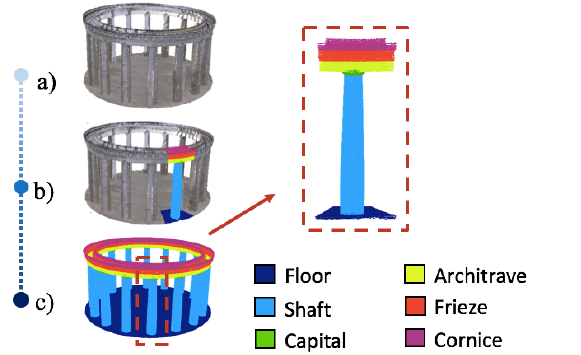
Figure 8. Mausoleum point cloud (a), annotated (b) and classified in 6 classes